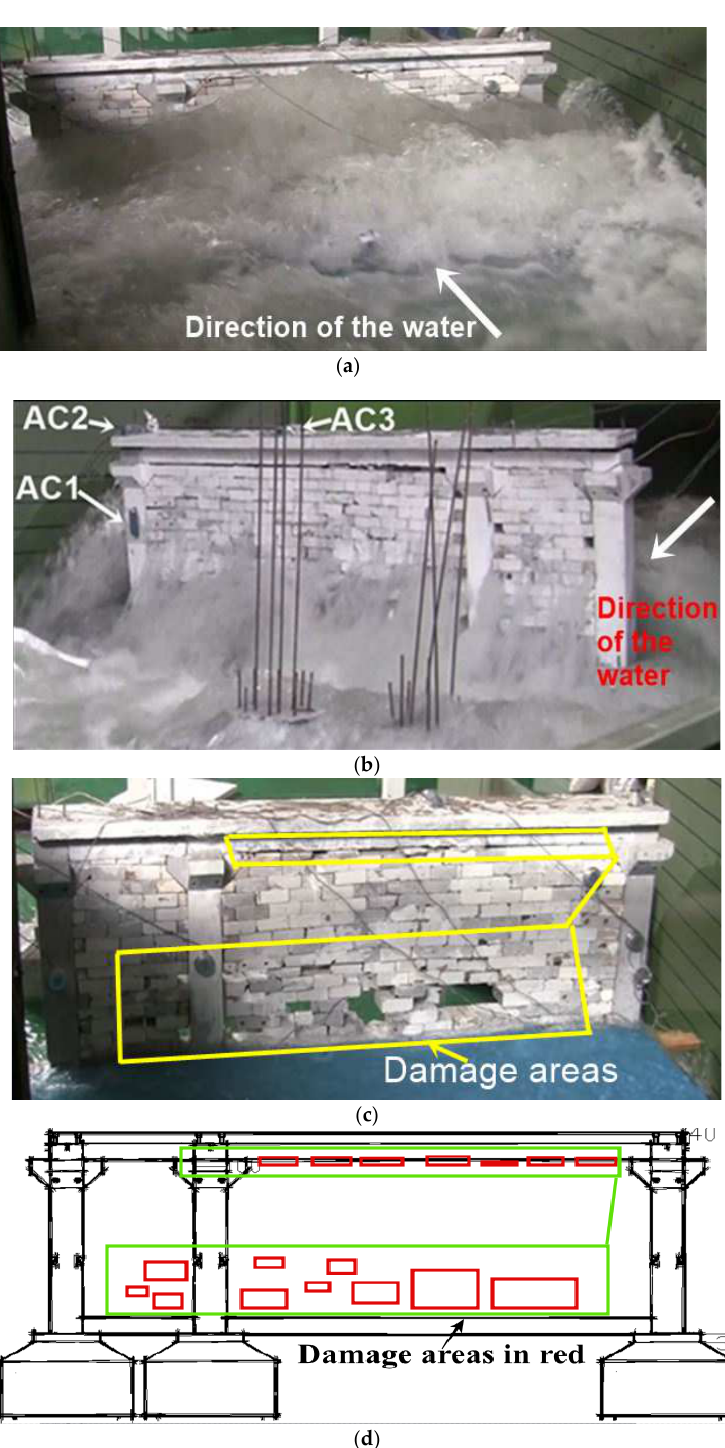
Figure 19. Dam-break test 3 for 3 m reservoir water level: ( a ) front of the frame during the test; ( b ) back of the frame during the test; ( c ) damage to the frame after test 3; ( d ) sketch of the damages.